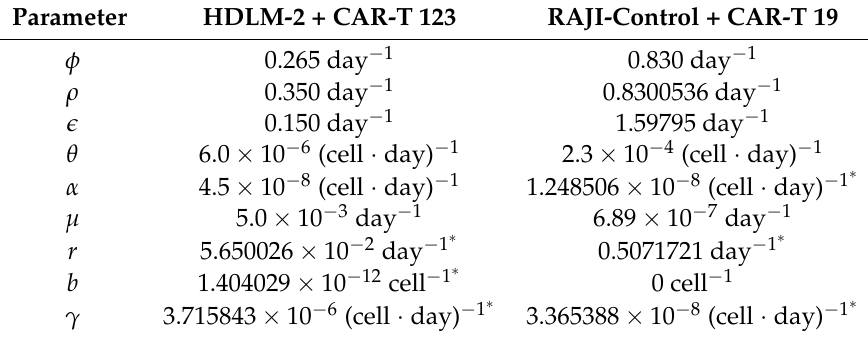
Table 2. Model parameter values used in the two immunotherapy scenarios. Additionally, in the RAJI-IDO + scenario, the parameters have the same values as for RAJI-control, except for the α parameter, with α = 1.461699 10 − 8 (cell day) − 1 for RAJI-IDO + + CAR-T 19 and α = 1.261662 × ·